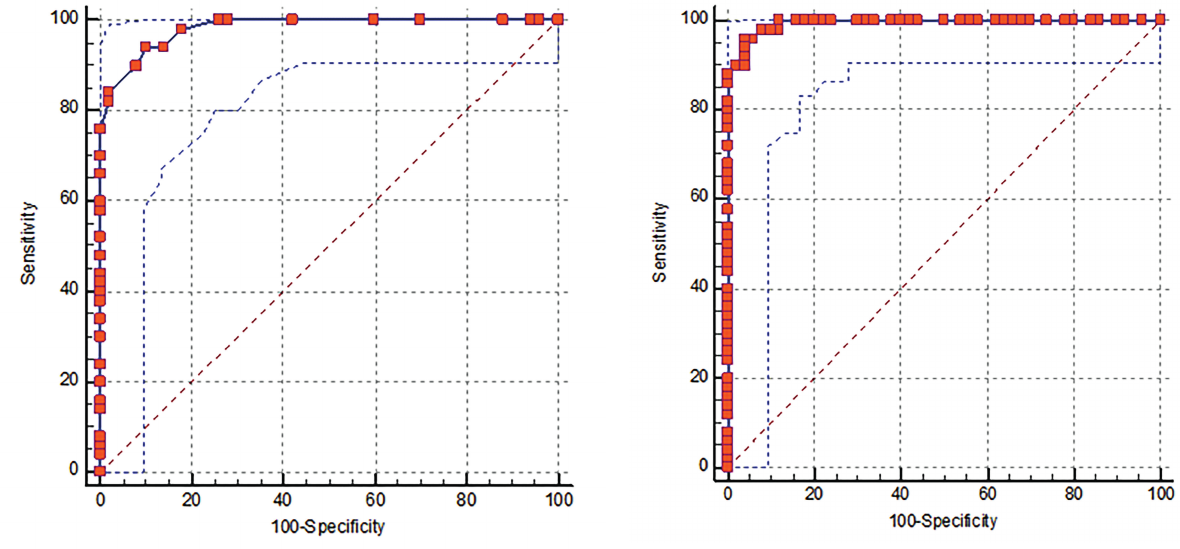
Figure 2 - The two graphics can be labeled as a and b for clarity. and the legend can be changed as: ROC analysis of R α (a) and BND (b) for